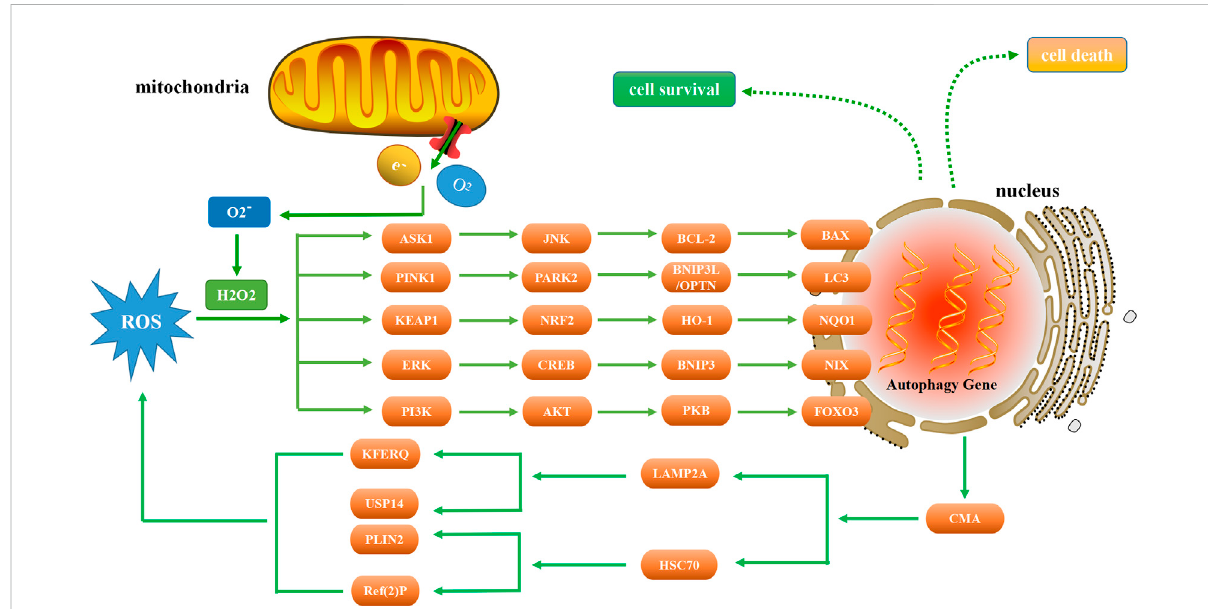
FIGURE 1 RelationshipbetweenautophagyandROS.Asasignalingmolecule,ROSregulatesautophagybytargetingASK1,PINK1,KEAP1,ERK,andPI3K.In thepresenceofexcessiveROS,ASK1andJNKareactivatedtophosphorylateBCL-2andincreasetheexpressionofBAX,therebyinducingautophagy. PINK1 activation can increase the level of PARK2, ubiquitinate BNIP3L, enhance the production of LC3, and thus induce autophagy. NRF2 is tightly regulated by KEAP1 and induces autophagy through the NRF2-HO-1-NQO1 pathway. When ERK is activated by ROS, autophagy is induced through theERK-CREB-BNIP3-NIX signaling pathway. Conversely, autophagy suppresses ROS accumulation by eliminating damaged mitochondria via the CMA pathway. ROS regulates the expression of PI3K, and the downstream AKT protein induces autophagy through the AKT-PKB- FOXO3